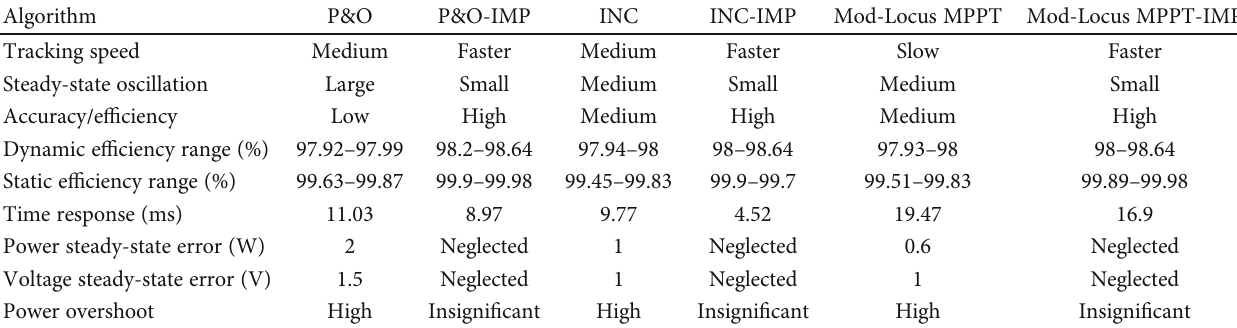
Table 2: Simulation result performance from the comparison of di ff erent MPPT control